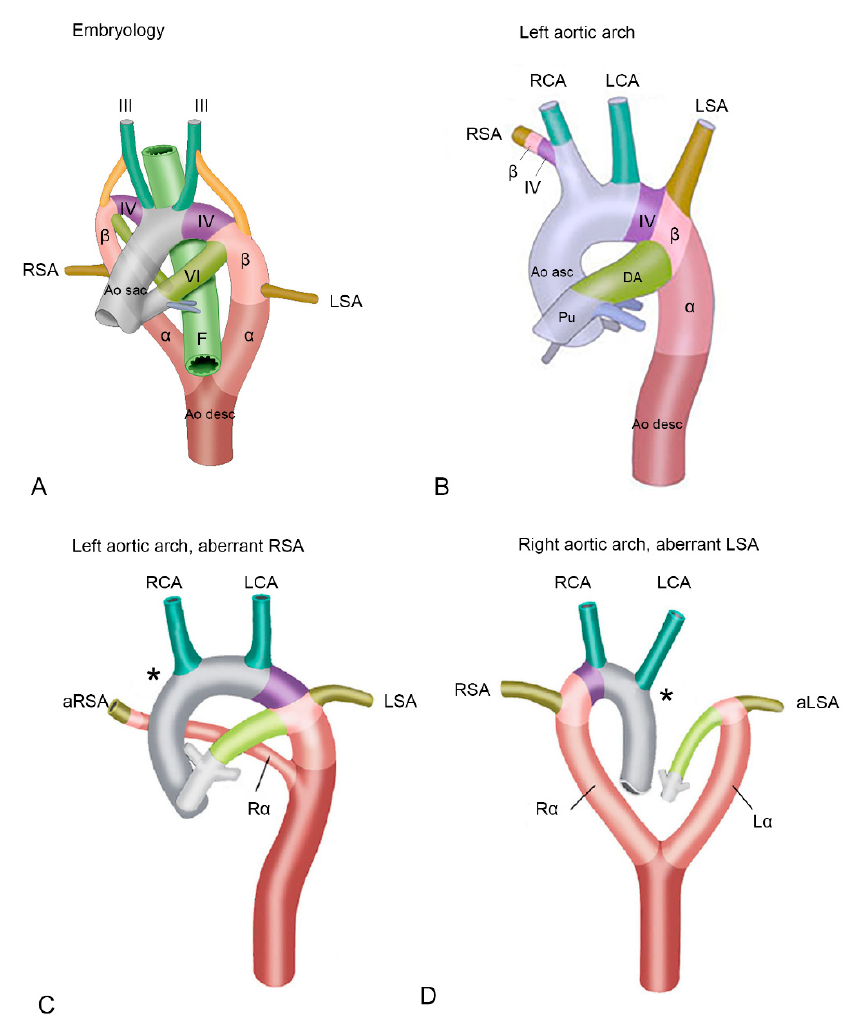
Figure 1. ( A ) Schematic overview of early development. Embryological segments are superimposed on the developing vascular system of the cardiac outflow tract. The vascular system evolves from an initially almost symmetrical bilateral system, into an asymmetrical system. Structures relevant to development of the outflow tract arteries are indicated. ( B ) Left sided aortic arch. The right 4th pharyngeal arch artery (PAA) and beta-segment now form the base of the right subclavian artery, connecting it to the aorta via the brachiocephalic artery. The right alpha-segment has regressed. ( C ) Left aortic arch with an aberrant right subclavian artery. Due to deficiency of the right 4th PAA (asterisk *), the proximal part of the right subclavian artery is deficient, and an aberrant right subclavian artery is connected distally to the aorta descendens via a persisting right alpha-segment. ( D ) Right aortic arch with an aberrant right subclavian artery. In this case, the left 4th PAA is deficient (asterisk *) and the aberrant left subclavian artery is connected to the aorta descendens via a persisting left alpha-segment. Abbreviations in the figure: α , alpha-segment; aLSA, aberrant left subclavian artery; Ao desc, descending aorta; Ao sac, aortic sac; aRSA, aberrant right subclavian artery; β , beta-segment; DA, ductus arteriosus; F, foregut (will later form a.o. esophagus and trachea); L α , left alpha-segment, LCA, left carotid artery; LSA, left subclavian artery; Pu, pulmonary trunk; R α , right alpha-segment; RCA, right carotid artery; RSA, right subclavian artery. III, IV and VI, 3rd, 4th and 6th pharyngeal arch arteries (PAA) respectively. Color coding: Grey, ascending aorta; green, carotid arteries, derived form 3rd PAA; purple, aortic B segment (in between carotid and subclavian artery, derived from 4th PAA, olive green, left subclavian arteries (derived from 7th intersegmental arteries); dark brown, descending aorta; dark pink, alpha-segment; light pink, beta-segment. Figures are modified with permission from Molin et al. Cardiovasc Res. 2002 [11] and Molin et.al Birth Defects Res A Clin Mol Teratol. 2004 [12].